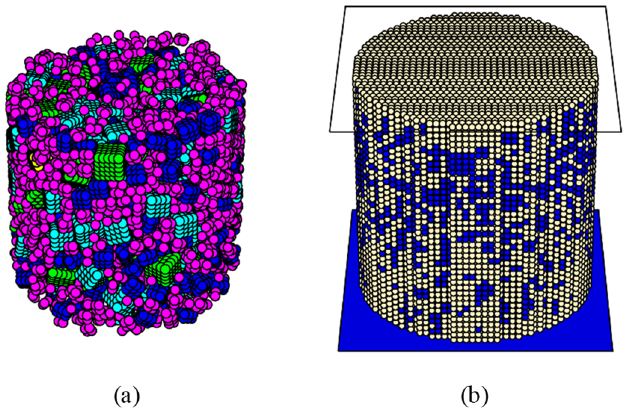
Figure 11. Digital specimen of asphalt mixtures: (a) aggregate skeleton; (b) specimen assembly.